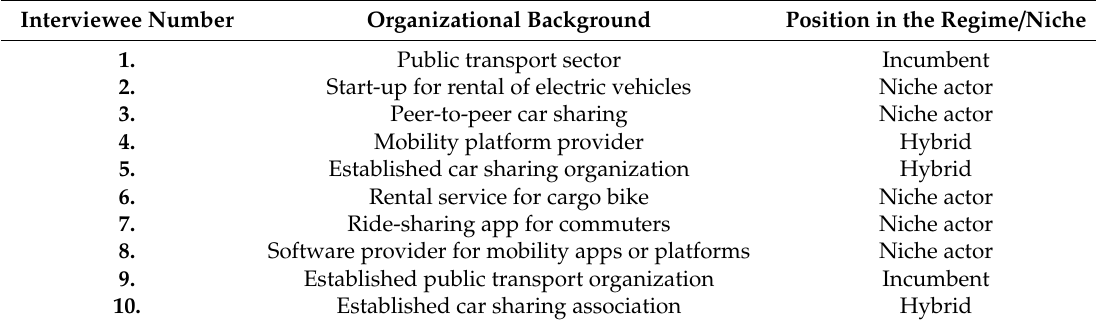
Table 1. Overview of the